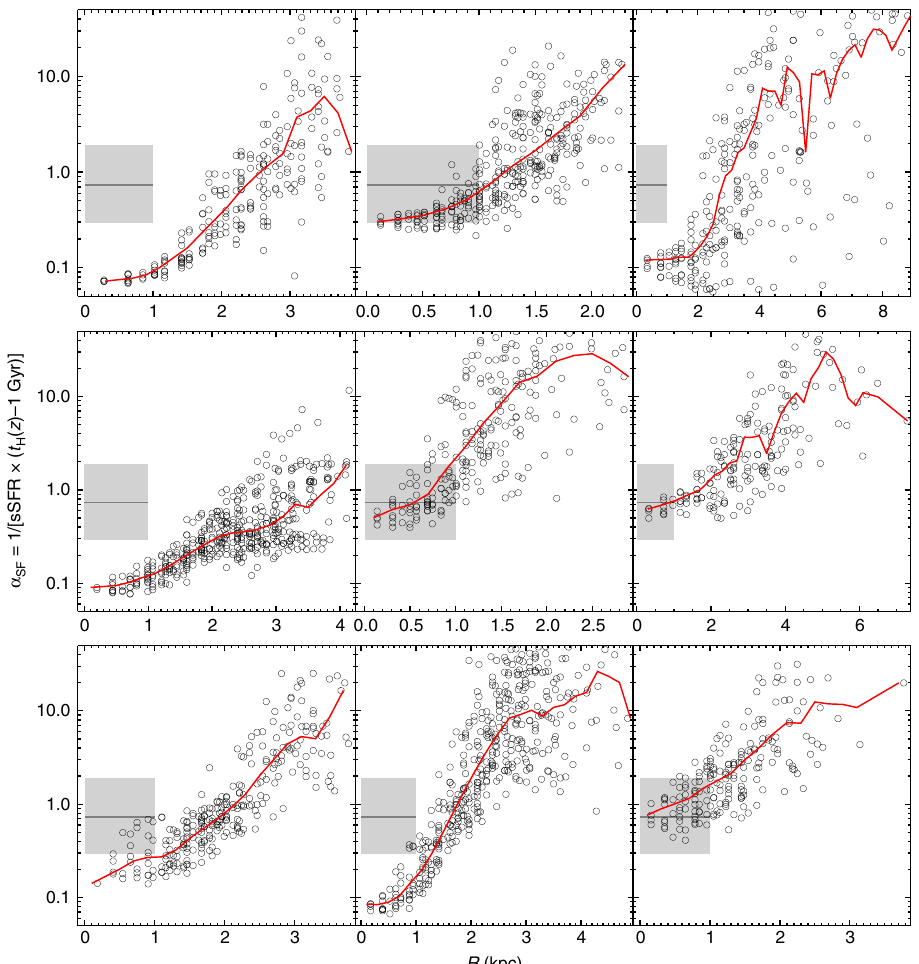
Figure 4 | The star formation activity parameter a SF versus radius for the nine blue star forming counter rotators. The circles are our data points while the red lines show the median. The grey shaded regions show the ± 1 s range of a SF for the central 1kpc of local star forming galaxies with D PA o 30 (cid:2) . Grey lines mark the median value of B 0.75.